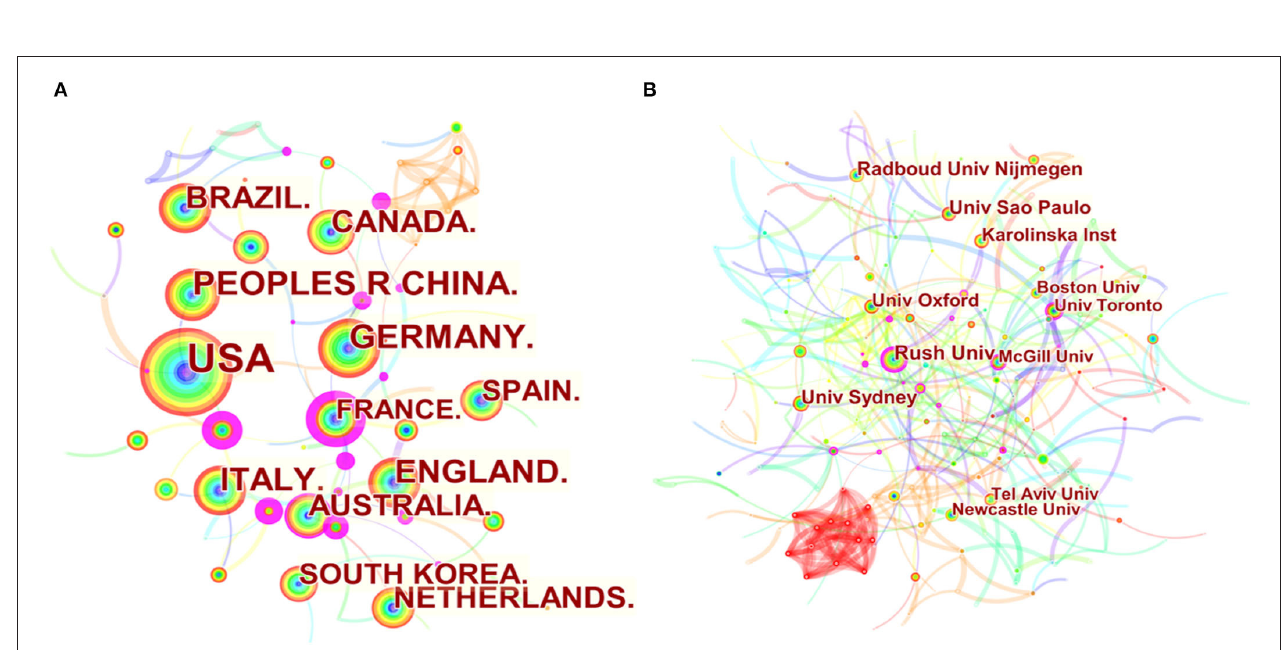
FIGURE 4 | Country and institutional maps of exercise on PD research. (A) Map of countries involved in exercise research on PD. (B) Map of institutions related to exercise on PD research.